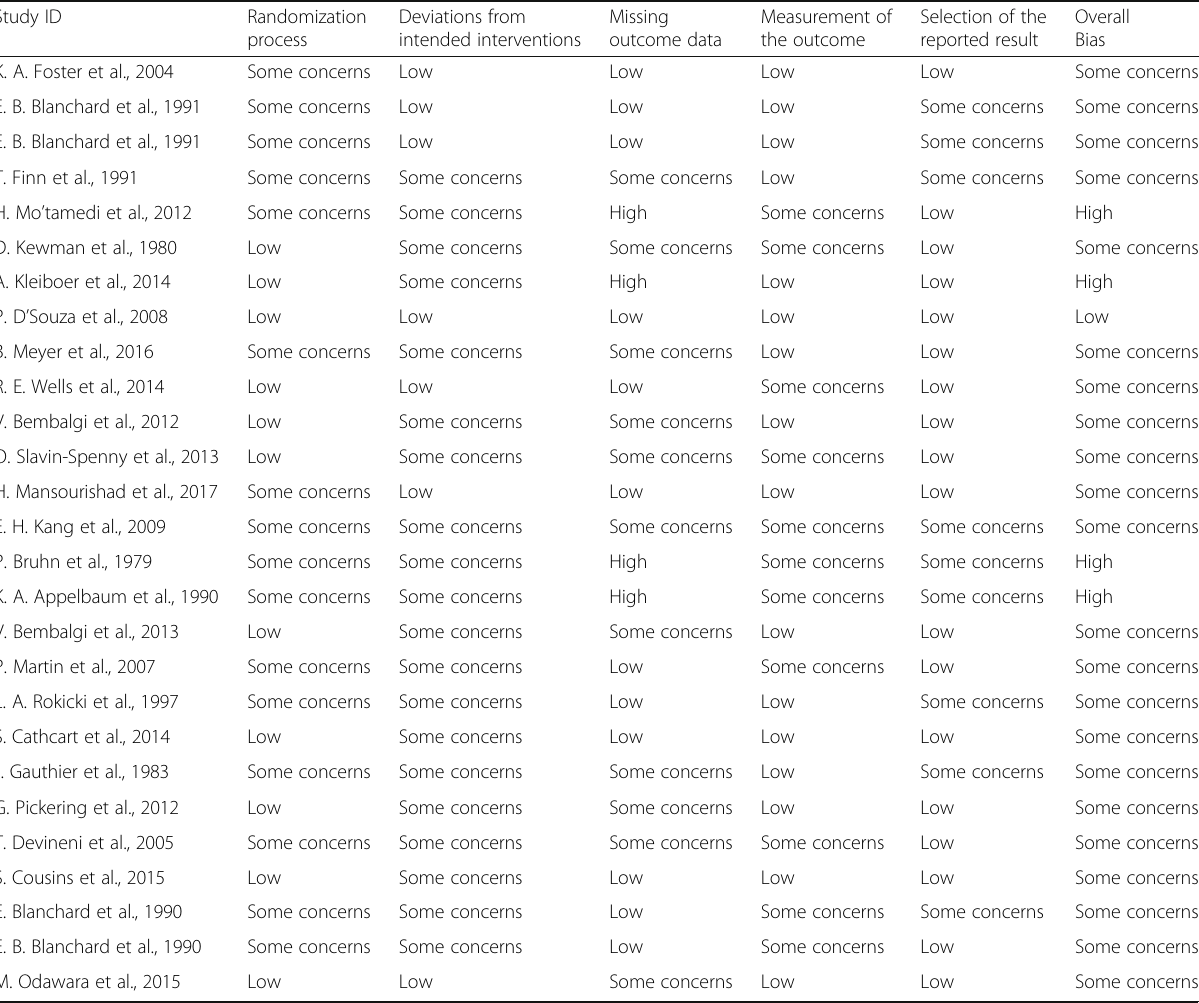
Table 2 Risk of bias of selected studies Study